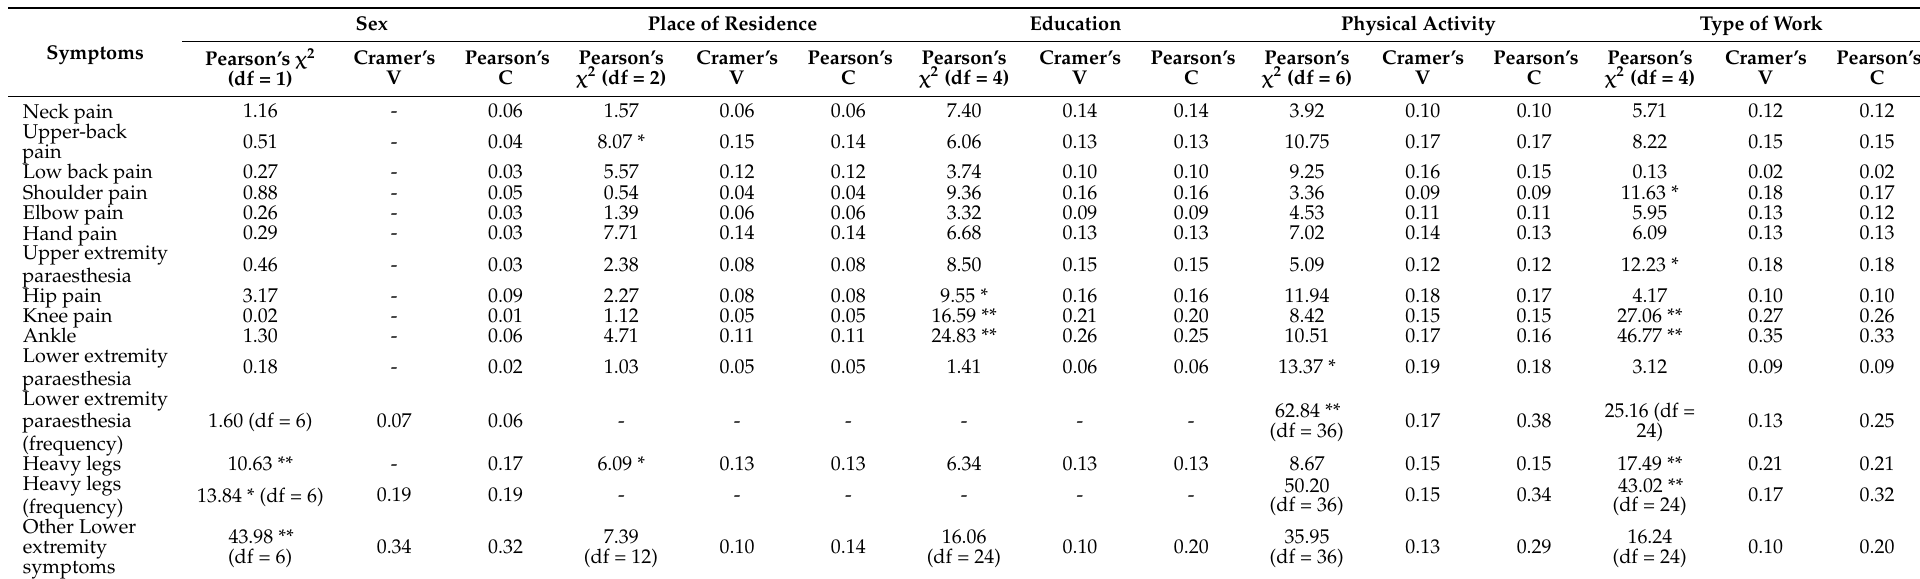
Table 3. Association between sociodemographic factors and pain prevalence at a given